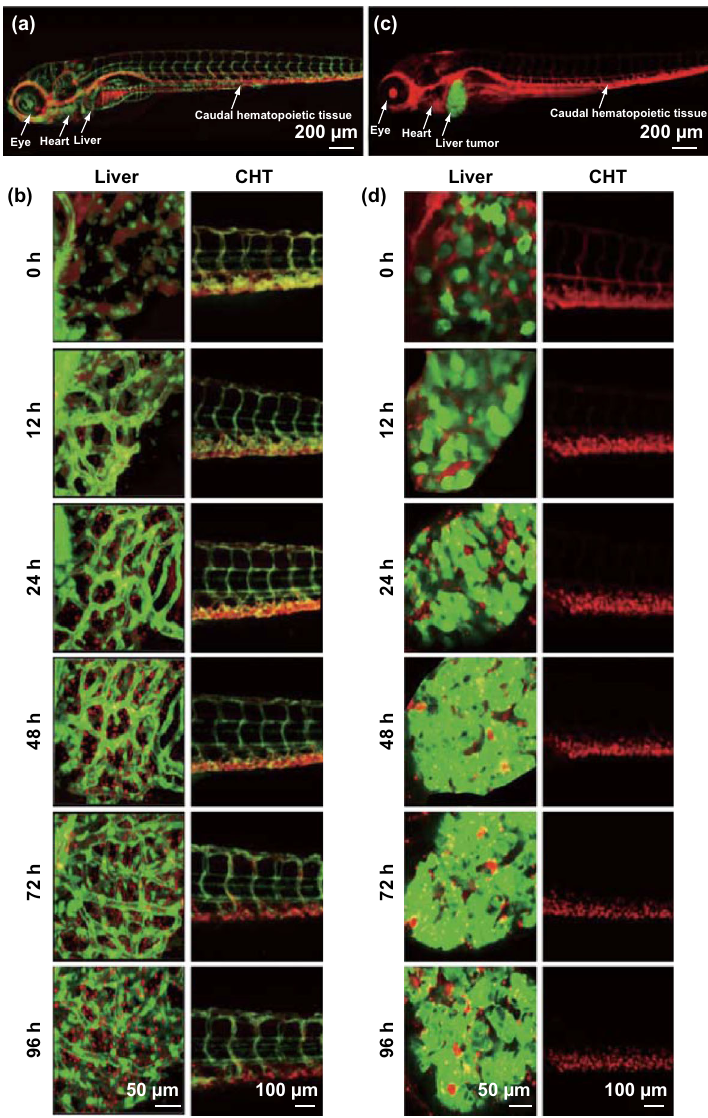
Fig. 3 a Confocal image of fli:EGFP zebrafish larva injected intravenously with 0.8 mg mL - 1 PPDCT NPs. b Uptake and breakdown of NPs over time span of 96 h in the liver and caudal hematopoietic tissue (CHT) of fli:EGFP zebrafish liver. c Confocal image of EGFP : kras V12 zebrafish larva injected intravenously with 0.8 mg mL - 1 PPDCT NPs. d Uptake and breakdown of NPs over time span of 96 h in the liver and CHT of EGFP : kras V12 zebrafish liver. Confocal k ex = 488 nm, green fluorescent protein k em = 509 nm, PPDCT k em = 660